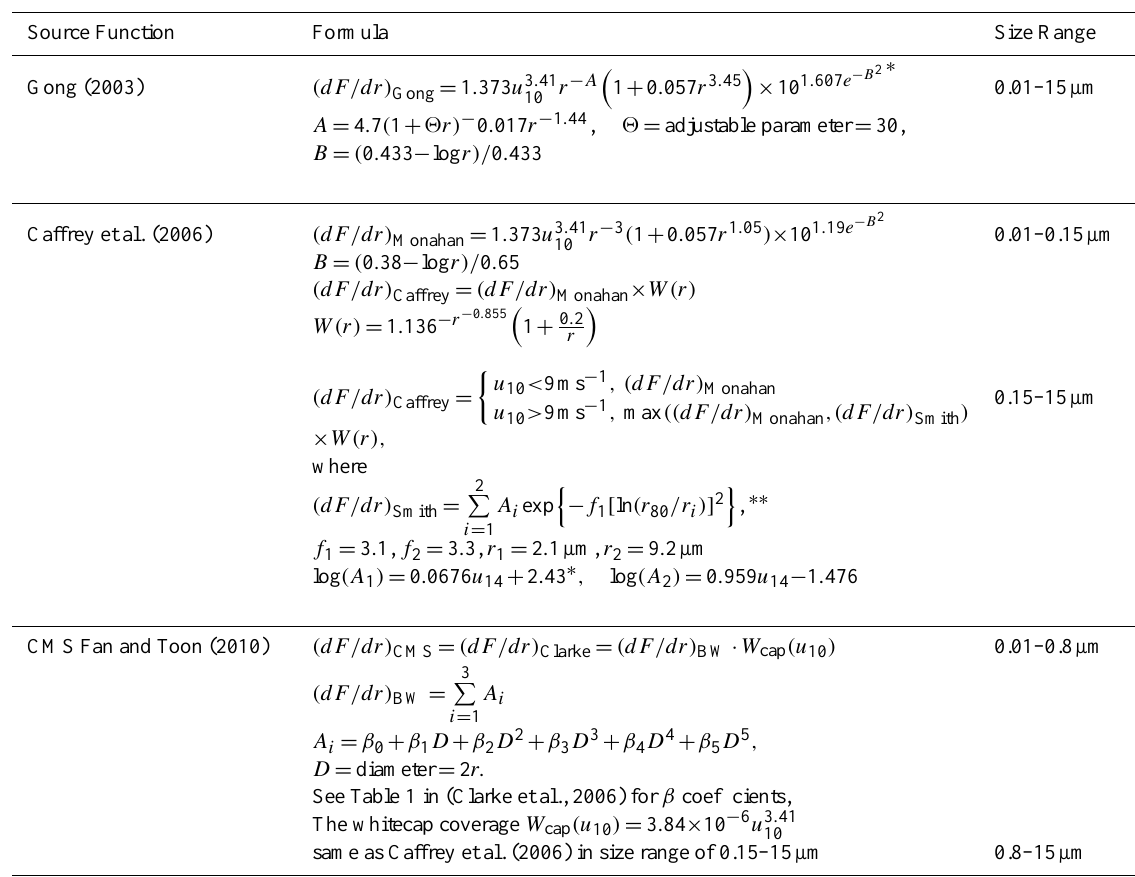
Table 1. Formulas for source functions compared in the paper, unit: m − 2 s − 1 µm − 1 . Source